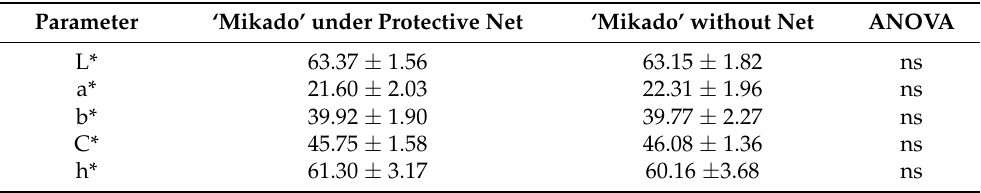
Table 2. External color coordinates of ‘Mikado’ apricot cultivar grown under protective net and without net. Mean values ± standard deviation ( n = 30).